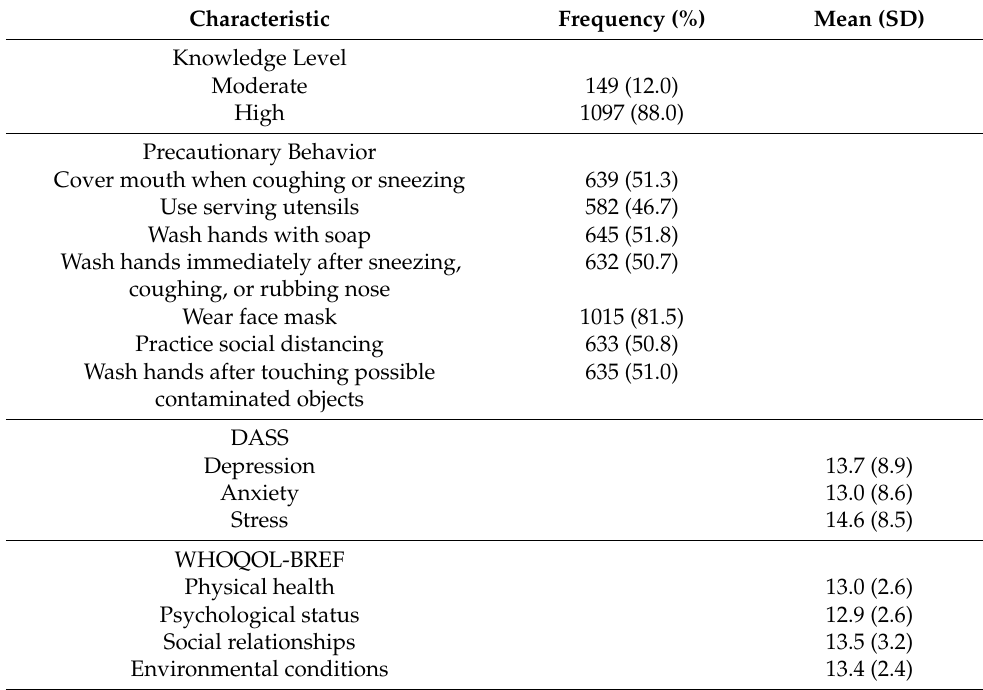
Table 2. Knowledge Level, Precautionary Behavior, Depression, Anxiety, and Stress Scales (DASS), and Quality of Life (WHOQOL-BREF) of